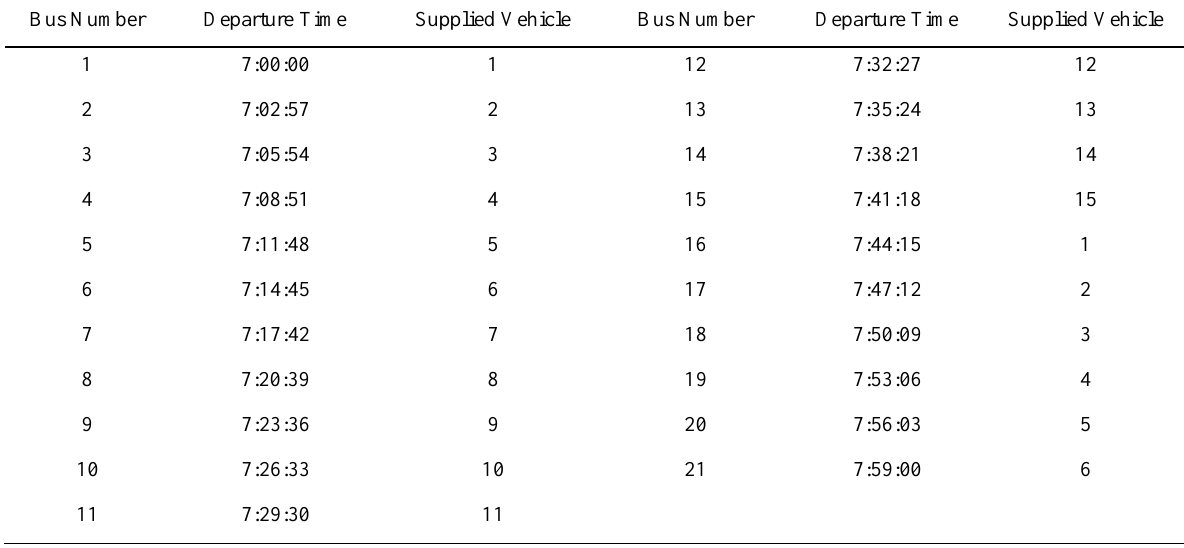
Table 4. The regular schedule with even interval and all-stop operation